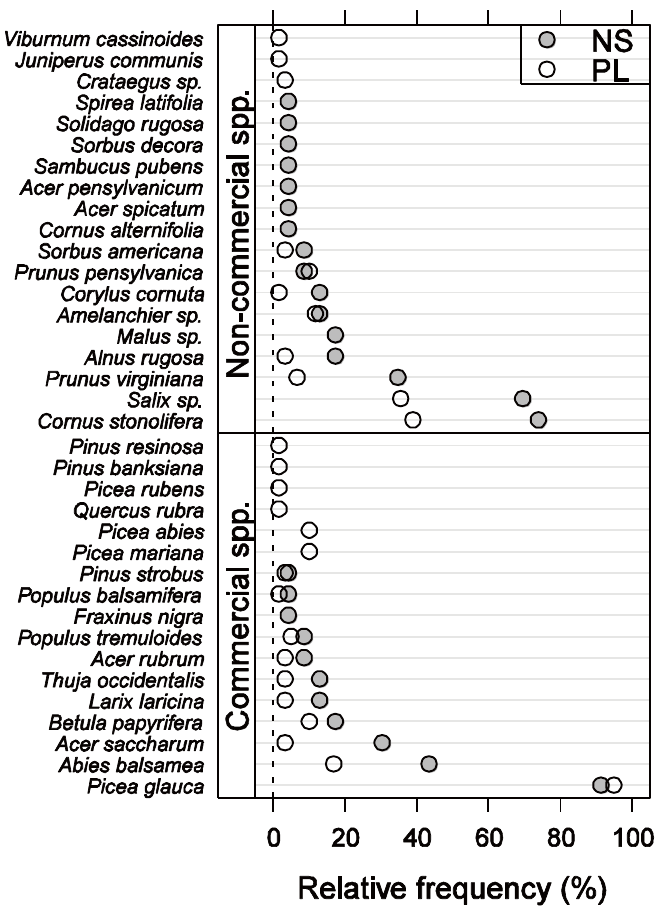
Figure 2. Relative frequency of commercial and non-commercial plant species for plantation (PL) and natural succession (NS) established on fallow lands.